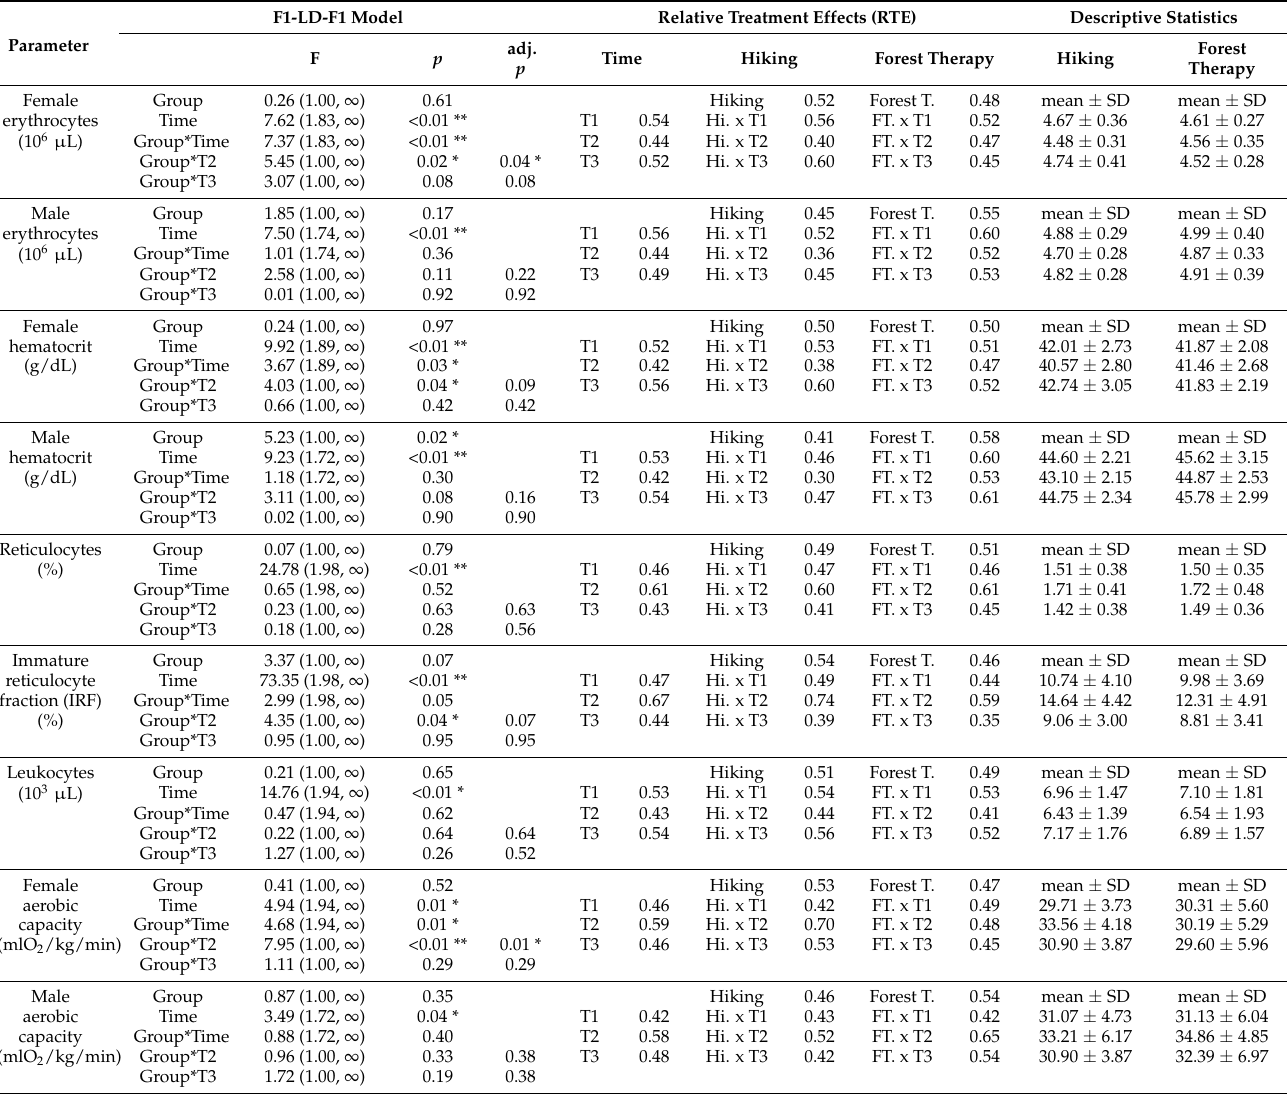
Table 4. Results from the F1-LD-F1-model for differential blood count and aerobic